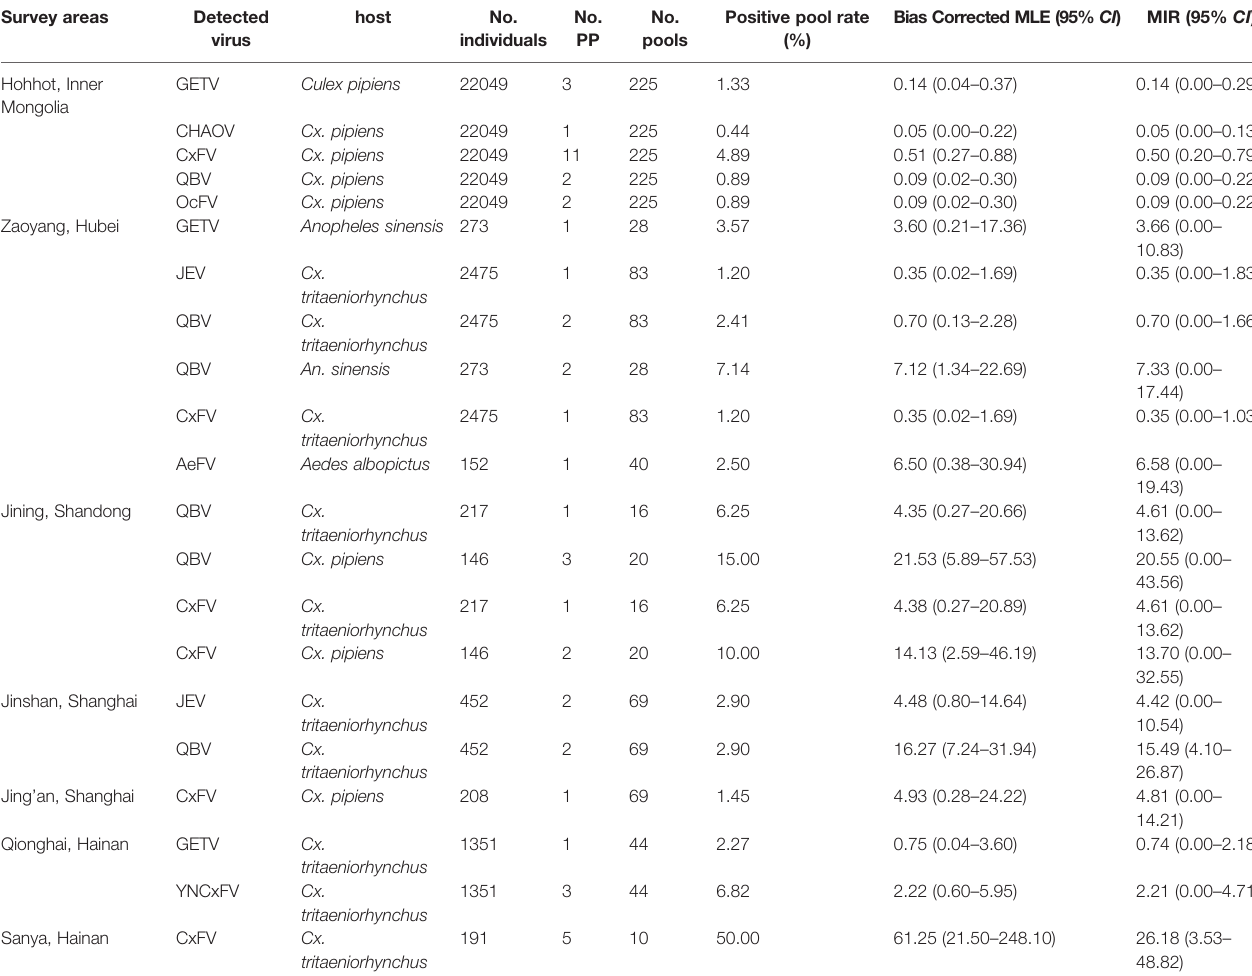
TABLE 2 | Bias-corrected maximal likelihood estimations (MLE) and minimum infection rates (MIR) of mosquito-borne fl aviviruses at various sentinel sites during the mosquito activity seasons of 2018. Survey